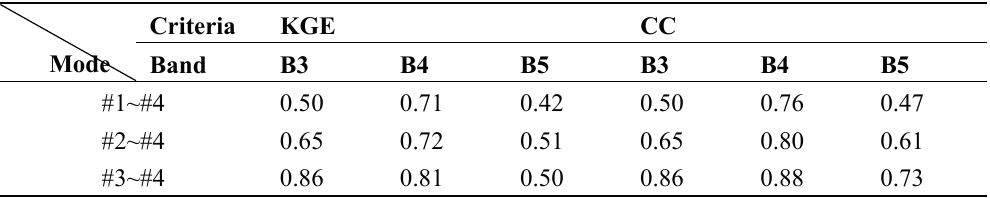
Table 4. The quantitative assessment of STARFM-One prediction performance using different prior input L-M pairs in the CIA site. For example, “#1~#4” denotes the prediction mode in which the L-M pair on 8 October 2001 (#1) and MODIS image on 9 November 2001 (#4) are used to predict Landsat-like fusion on 9 November 2001